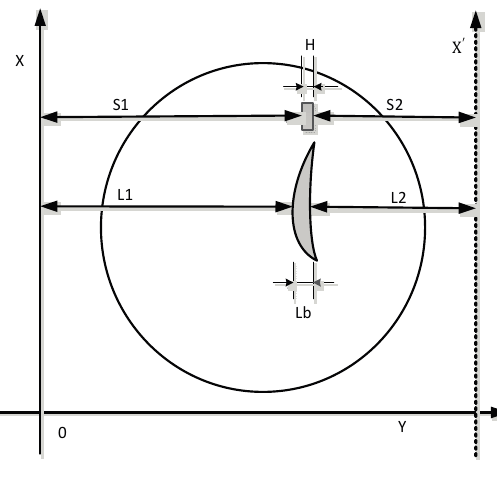
Figure 12. Measuring points sectional diagram